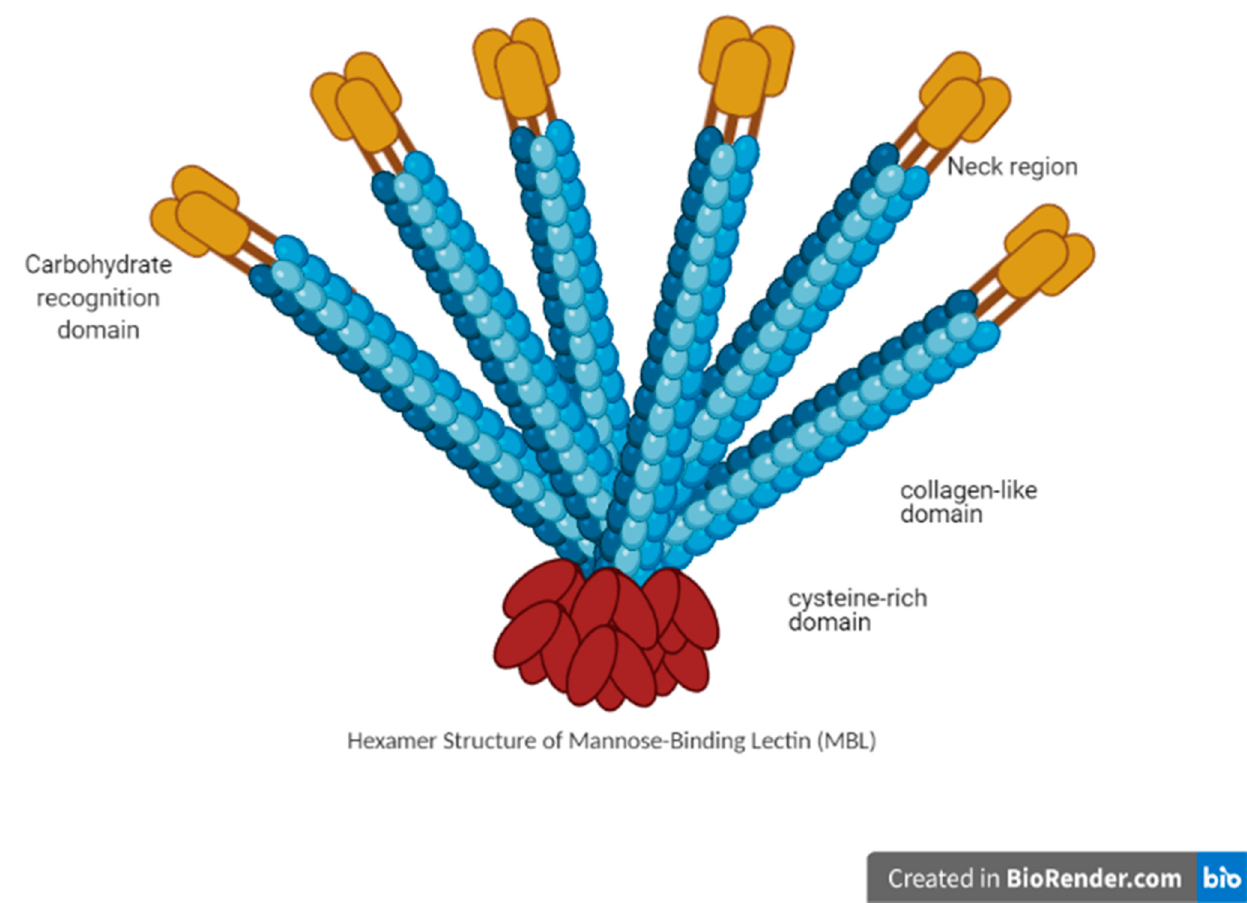
Figure 2. The multimeric structure of mannose-binding lectin (MBL).